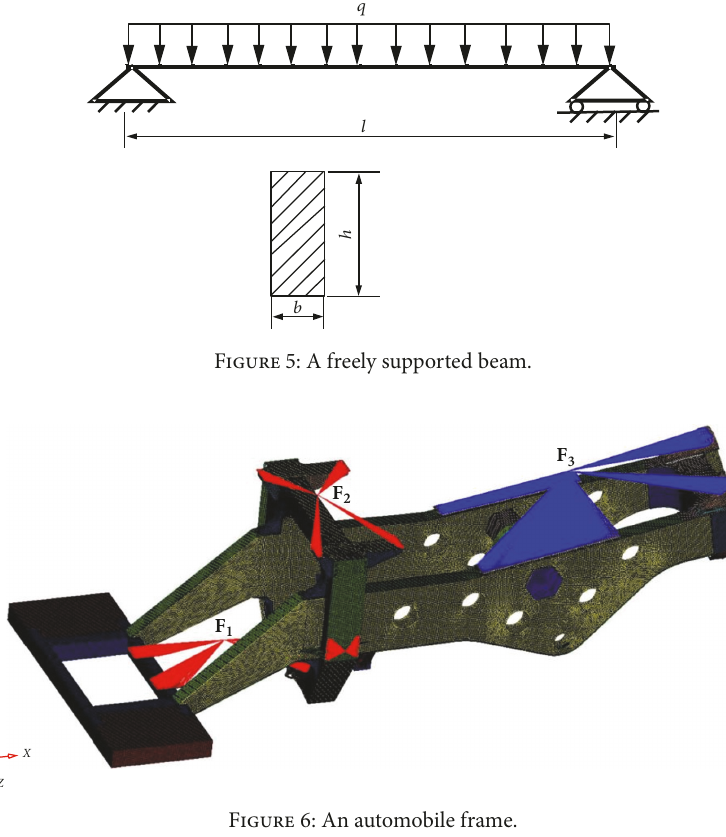
Figure 6: An automobile